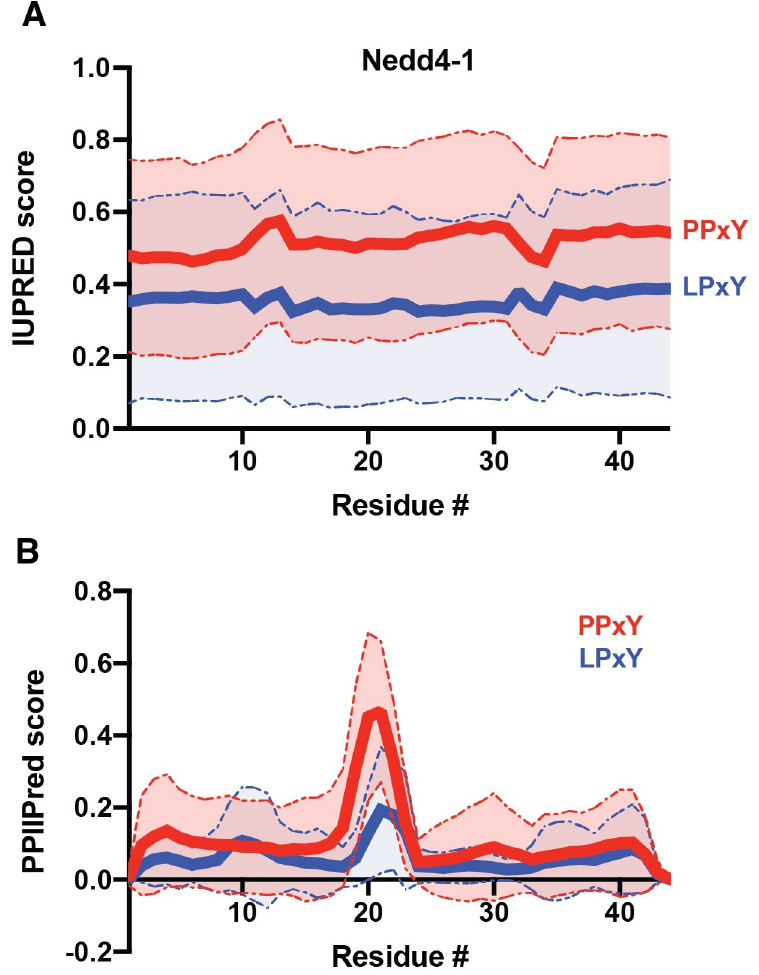
Fig 5. Prediction of relative order of PY-motif containing regions from the Nedd4 interactome. PY motif sequences ± 20 amino acids were extracted from the Nedd4 interactome using PxYFinder script and analyzed